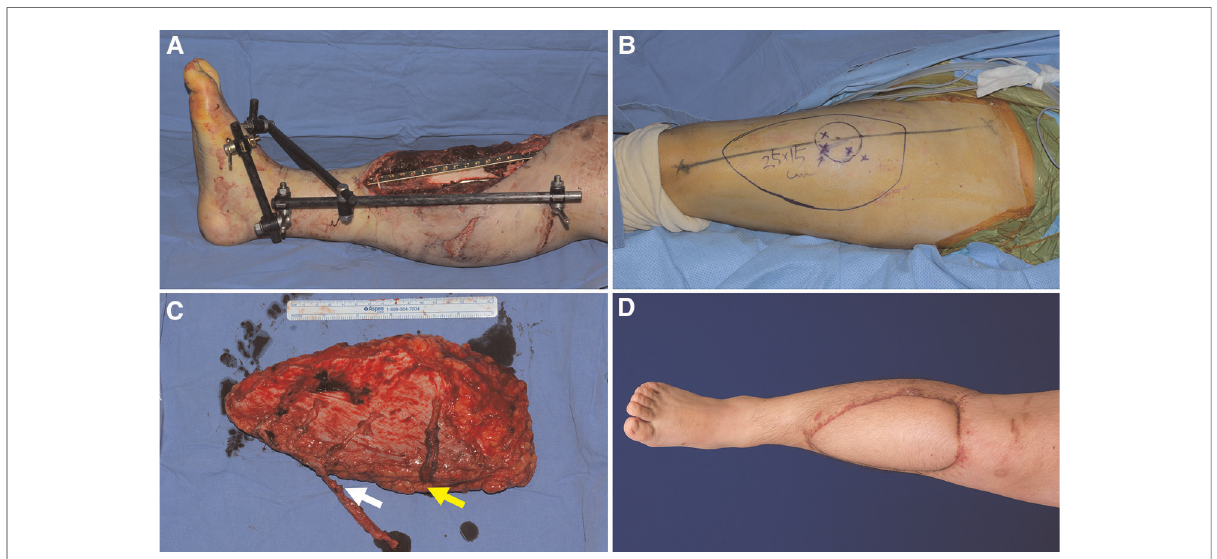
FIGURE 8 A clinical case presenting reconstruction with a wide ALTP fl ap where the turbocharging procedure was performed after harvesting the fl ap. (Each arrow indicates as follows: yellow indicates a perforator from TB-LCFA; white indicates side branches of DB-LCFA) ( A ) An 18-year-old man sustained severe bone and soft tissue injuries in the right lower leg from a motorcycle accident. ( B ) A wide ALTP fl ap (25×15 cm 2 ) was designed. ( C ) The fl ap was harvested without the turbocharging procedure because the main pedicle was possibly expected to be critically shortened by adding a turbocharged supplying vessel because the fl ap already had three perforators from DB-LCFA. ( D ) A photograph was taken 21 months after reconstruction using a wide turbocharged ALTP fl